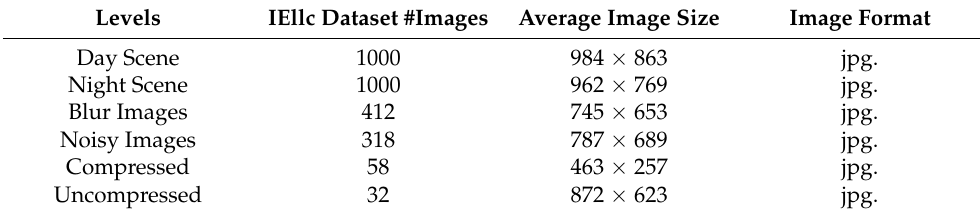
Table 1. IELLc Dataset Specification.